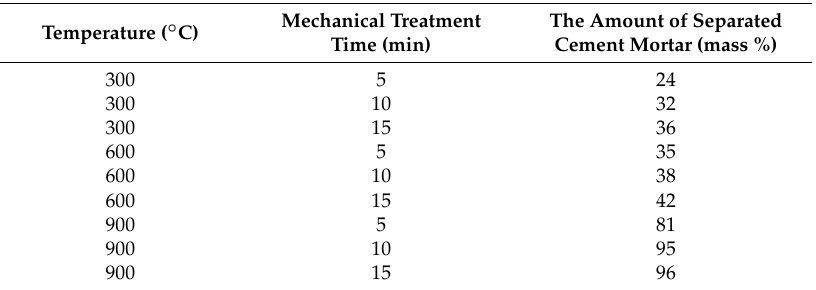
Table 3. The amount of separated cement mortar.